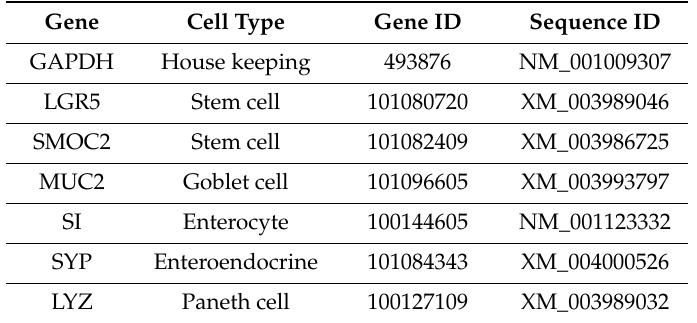
Table 2. Feline specific primers used to control cell population in tissue and